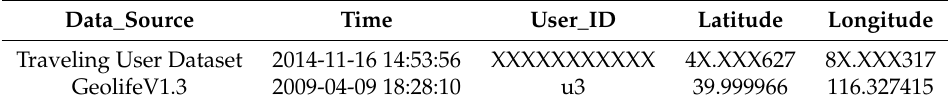
Table 1. Data pre-processed form (from two data